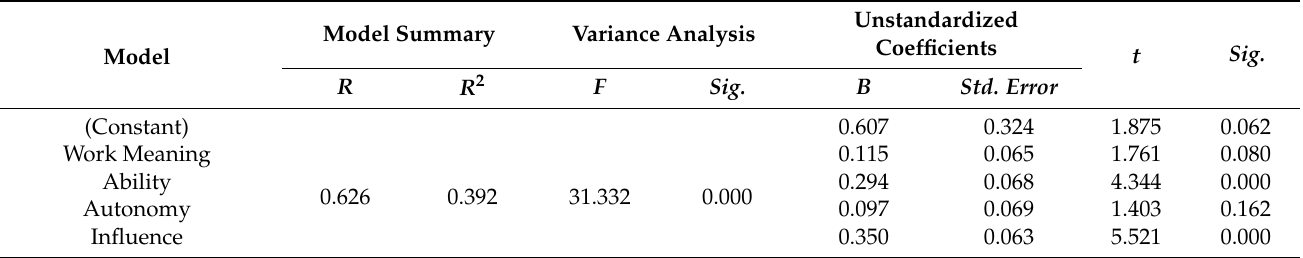
Table 20. Regression Analysis of Psychological Empowerment on Employee Relationship Perfor- mance.